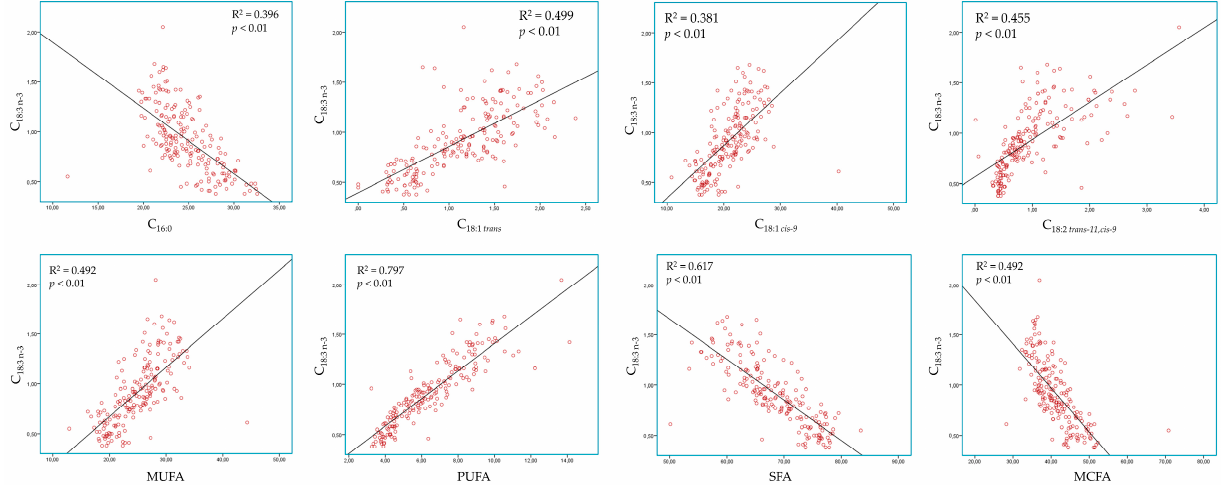
, CSS11; red , and (cid:35) (cid:51)